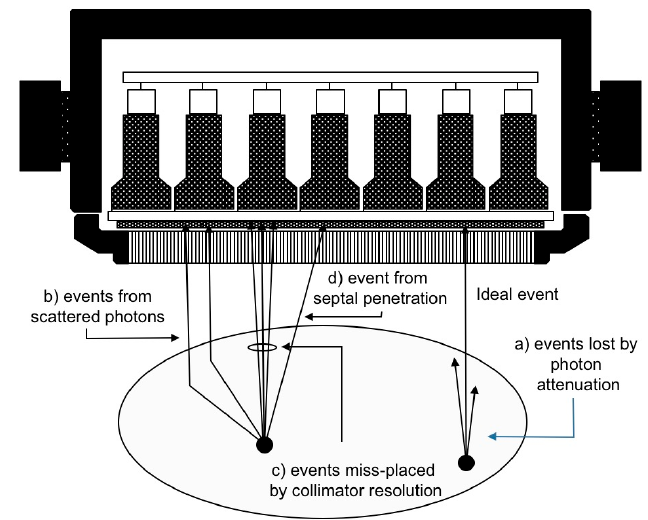
Figure 4. Schematic sketch showing the principles behind photon attenuation, scatter and collimator resolution effects (geometric resolution and effects from septal penetration).